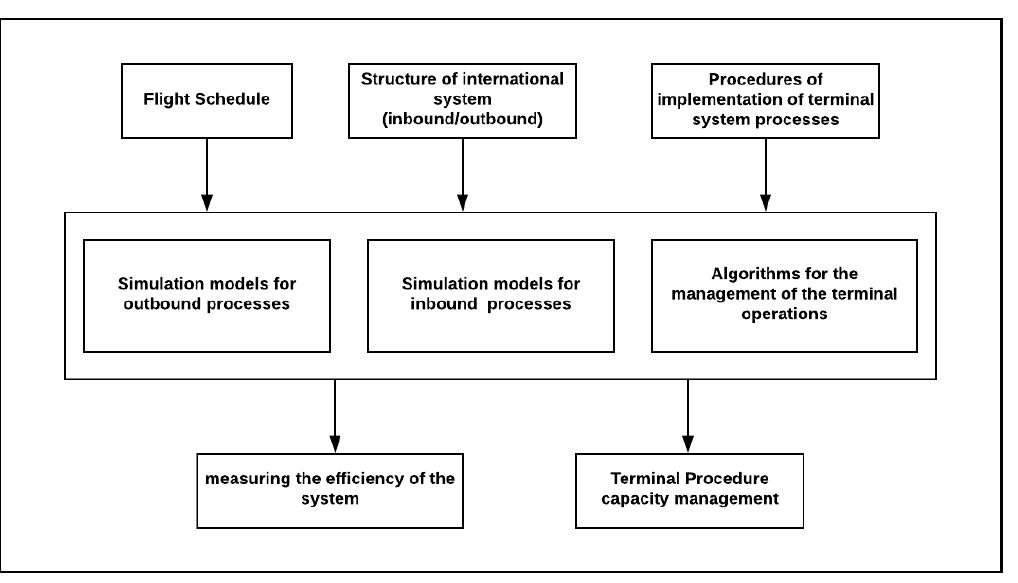
Figure 1. Airport system model [19].